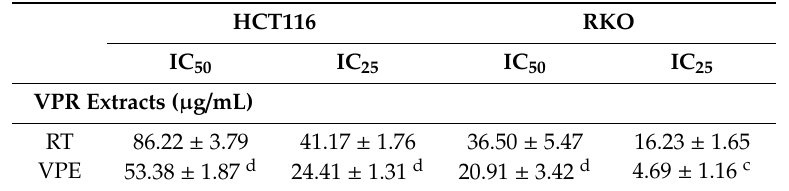
Table 2. IC 50 and IC 25 values of vine pruning residue (VPR) extracts in HCT116 and RKO cells after 48 h of treatment (expressed in µ g / mL).